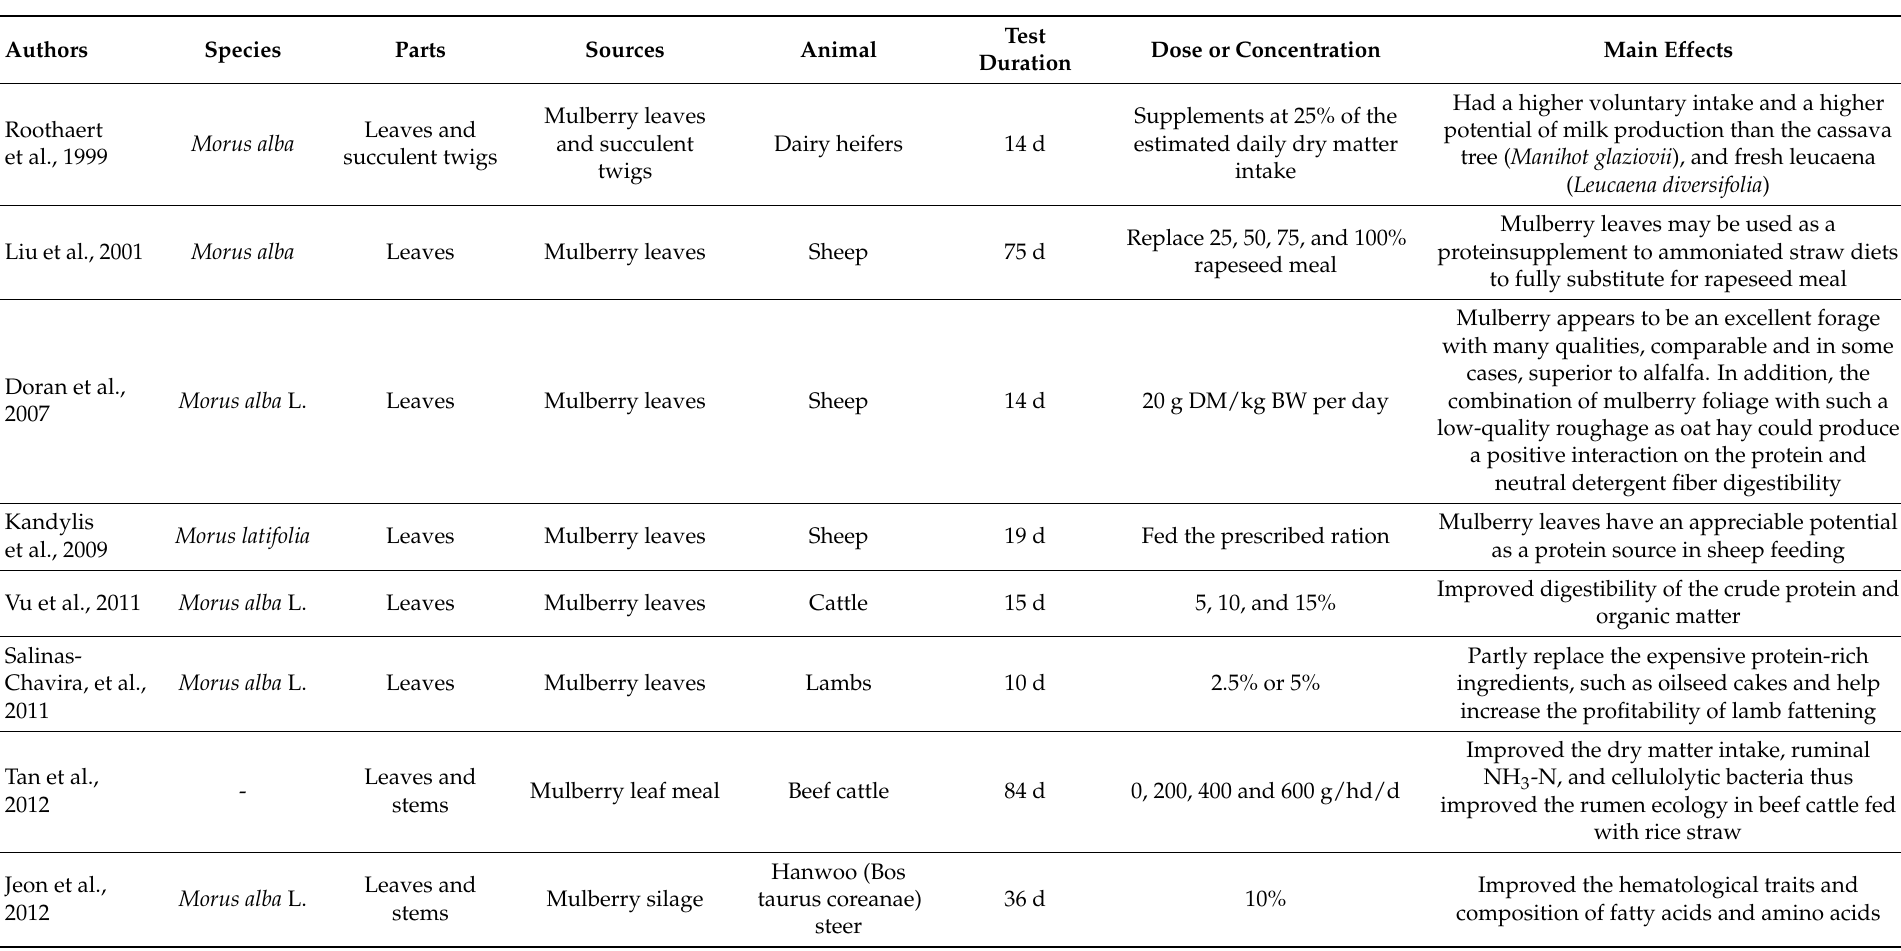
Table 5. The application of mulberry tree extracts on